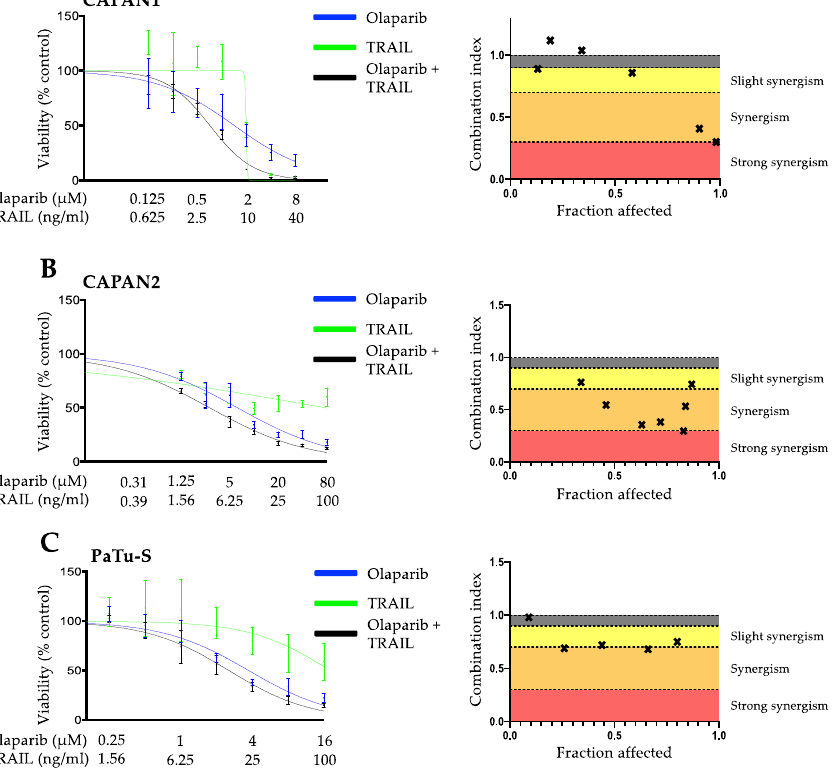
Figure 1. Olaparib and TRAIL synergize in killing pancreatic cancer cell lines. A-C proliferation assays of the effects of olaparib, TRAIL, or their combination on CAPAN1 ( A ), CAPAN2 ( B ), and PaTu-S ( C ). Cells were treated for 6 days with the indicated agents and subsequently analyzed via SYBR green proliferation assay. All experiments were performed in triplicate with error bars representing SEM from three independent experiments. Drug interactions were analyzed using the Chou–Talalay method with a combination index (CI) of <1, 1, and >1 indicating synergistic, additive, and antagonistic drug effects, respectively. In the combination index graphs, dots depict the CI at the respective fraction of cancer cells affected (x-axis, 0.0 = no cells dead, 1.0 = all cells